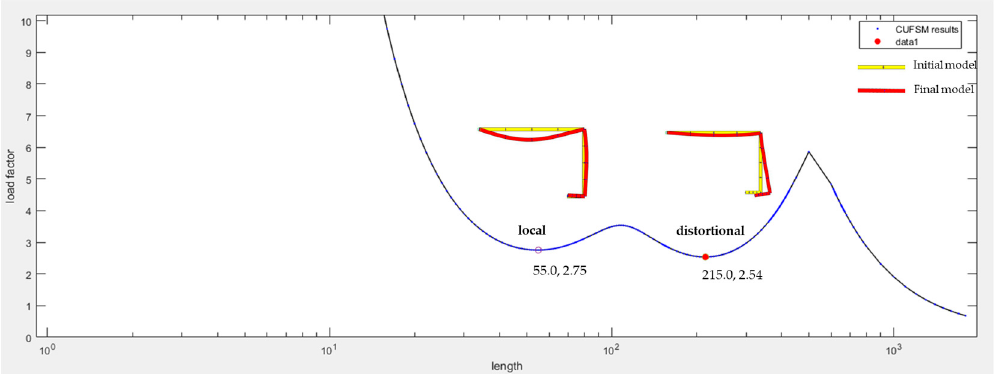
Figure 6. Complex edge stiffener signature curve for a 2 : a 1 = 0.25.